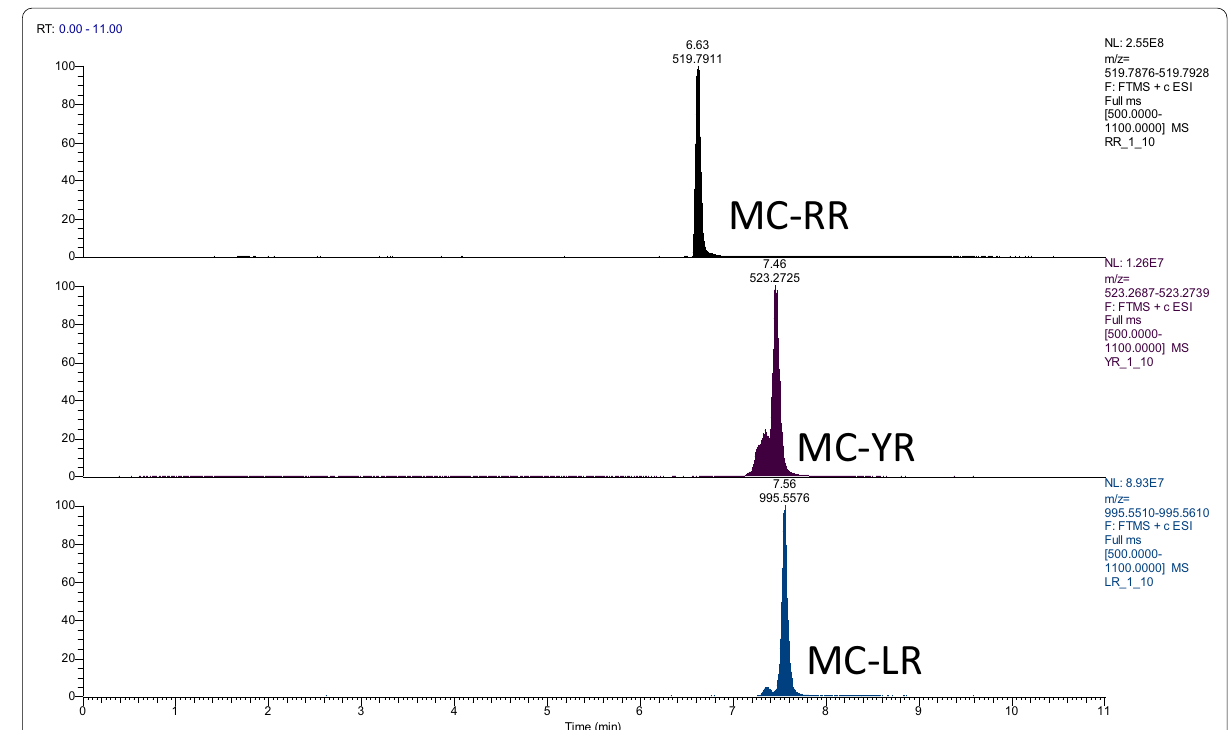
Fig. 3 Extracted ion chromatograms of a standard mixture containing microcystin-RR, -RL and -YR (certified reference material) at a concentration of 50 µg L − 1